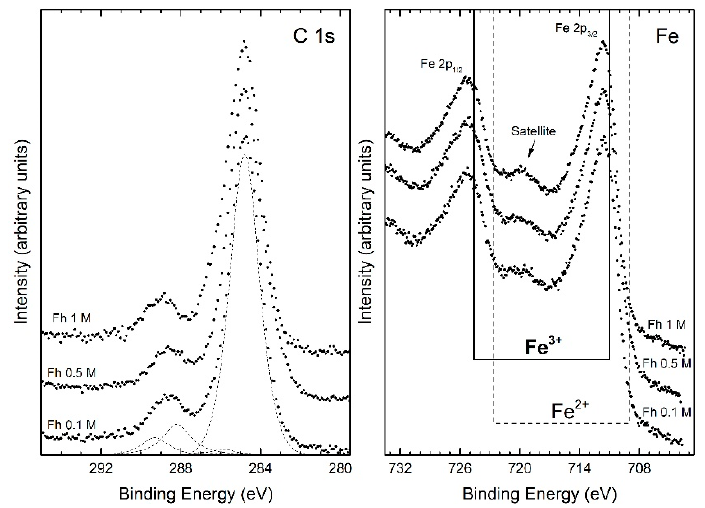
Figure 2. Core level C 1s and Fe 2p XPS spectra of samples at different initial chloride concentrations: 0.1 M, 0.5 M, and 1 M.